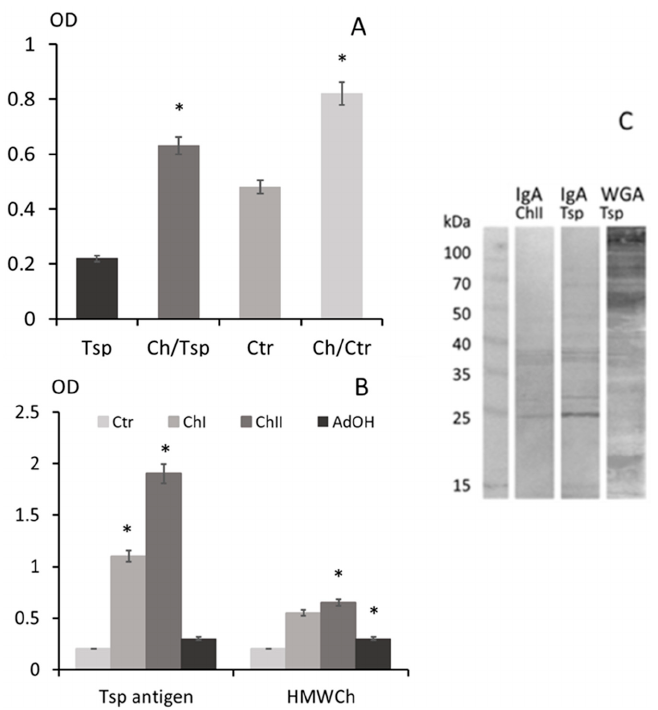
Figure 4. IgA response in the peritoneal cavity of T. spiralis infected mice, either with or without chitosan treatment; the level of IgA specific to muscle larvae somatic antigen identified by ELISA ( A ); the IgA of mice only injected with chitosan recognized T. spiralis larvae antigen and high molecular weight chitosan on a ELISA plate ( B ); Western-blot analysis showed that peritoneal IgA from mice injected with chitosan (ChII) and from mice infected with T. spiralis (Tsp) recognized similar glycoprotein bands on somatic larvae antigen at 30 DAI; WGA recognized GlcNAc residues between 50 kDa and 35 kDa. (*) p < 0.05 chitosan vs. non treated. The IgA induced by chitosan cross-reacted with T. spiralis muscle larvae antigens.